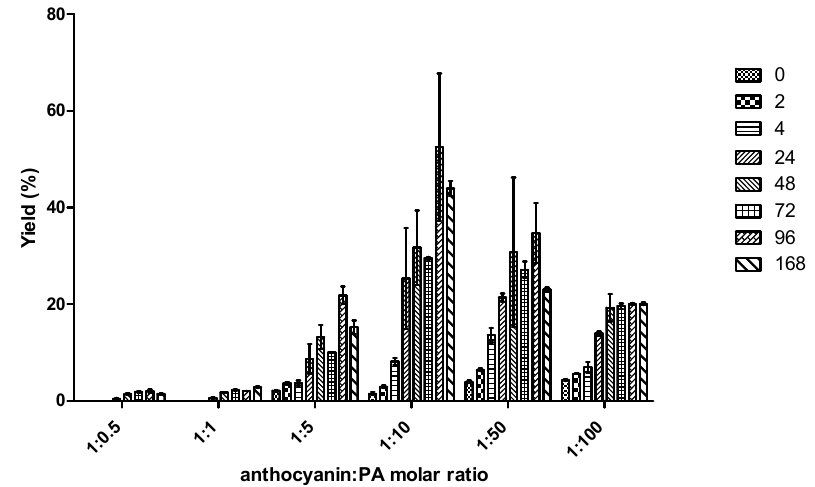
Figure 3. Mean of the yields (%) (triplicate) ± SD of formation of A-type vitisin after 0, 2, 4, 7, 24, 48, 72, 96, and 168 h of reaction between mv-3-glc and PA at different molar ratios mv-3-glc:PA 1:0.5, 1:1,